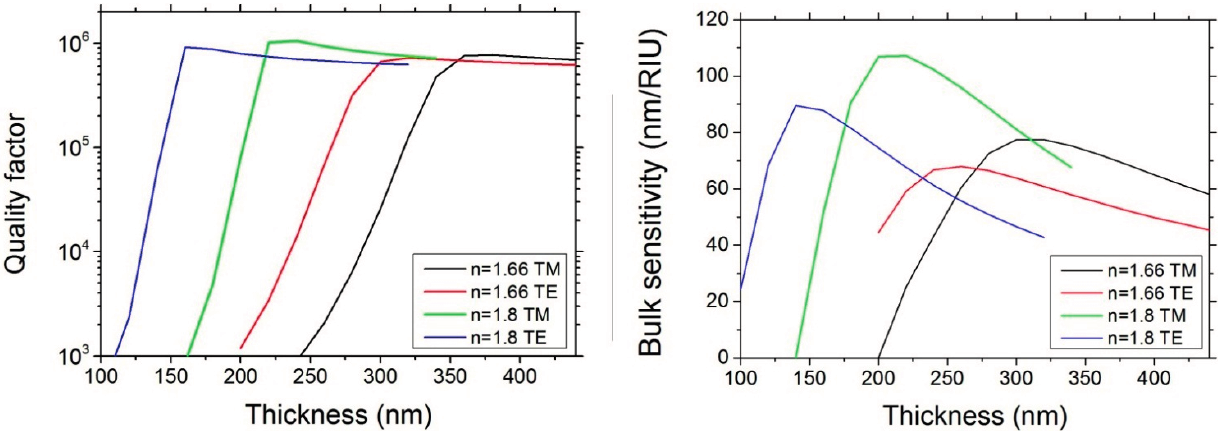
Figure 1. ( Left ) Quality factors in function of the waveguide thickness simulated for n SiON = 1.66 and 1.8 for both transverse electric (TE) and transverse magnetic (TM) polarizations; ( Right ) Bulk sensitivity in function of the waveguide thickness simulated for n SiON = 1.66 and 1.8 for both TE and TM polarizations.